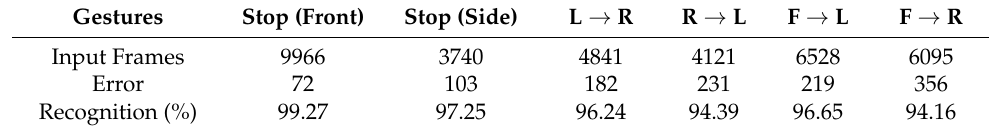
Table 1. Recognition efficiency of common traffic control hand gestures by our CNN